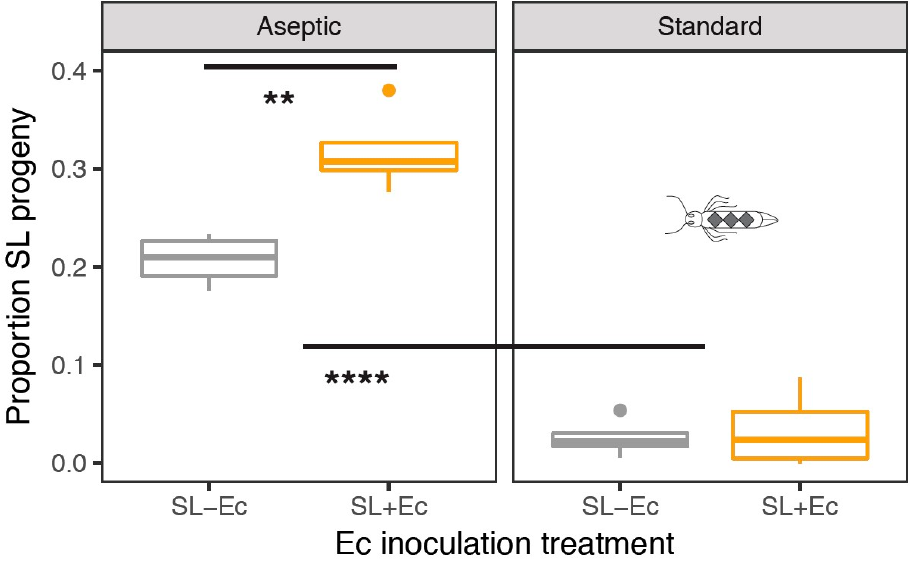
Figure 4. The impact of rearing regime and inoculation with E. cloacae gut bacteria on fitness of self-limiting males in mating competition experiments. Here, fitness is measured from the proportion of transgenic fluorescent male SL progeny in cages with 10:1 SL: Wild type release ratio and 120 insects per cage. In the aseptic regime, we scored a minimum of 100 progeny per mating cage; in the standard treatment, 200–400 progeny were scored per cage. Asterisks indicate significantly different treatment contrasts (** p < 0.01, **** p < 0.0001).